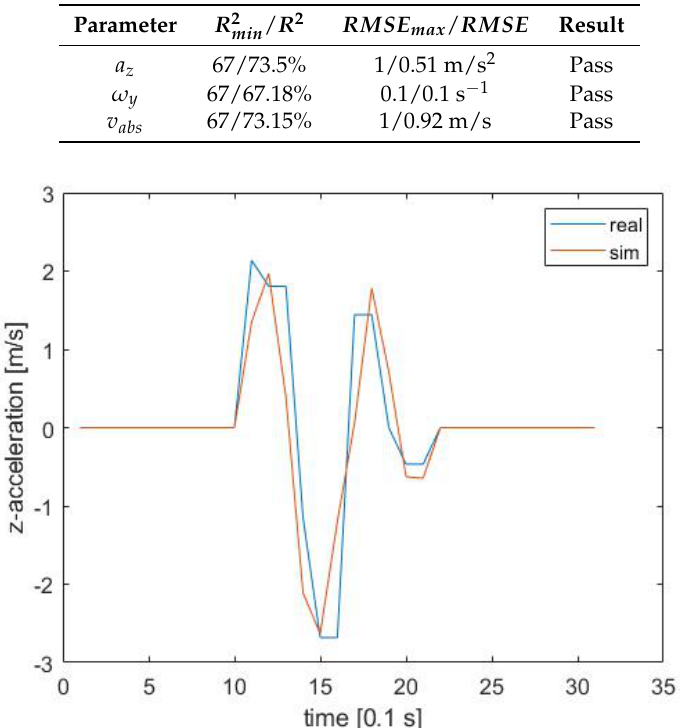
Table 3. Minimum validation criteria and experimental results.